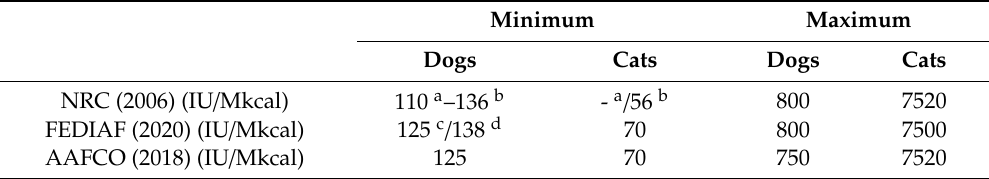
Table 2. Minimum and maximum recommendations of dietary cholecalciferol for growing puppies and kittens according to scientific